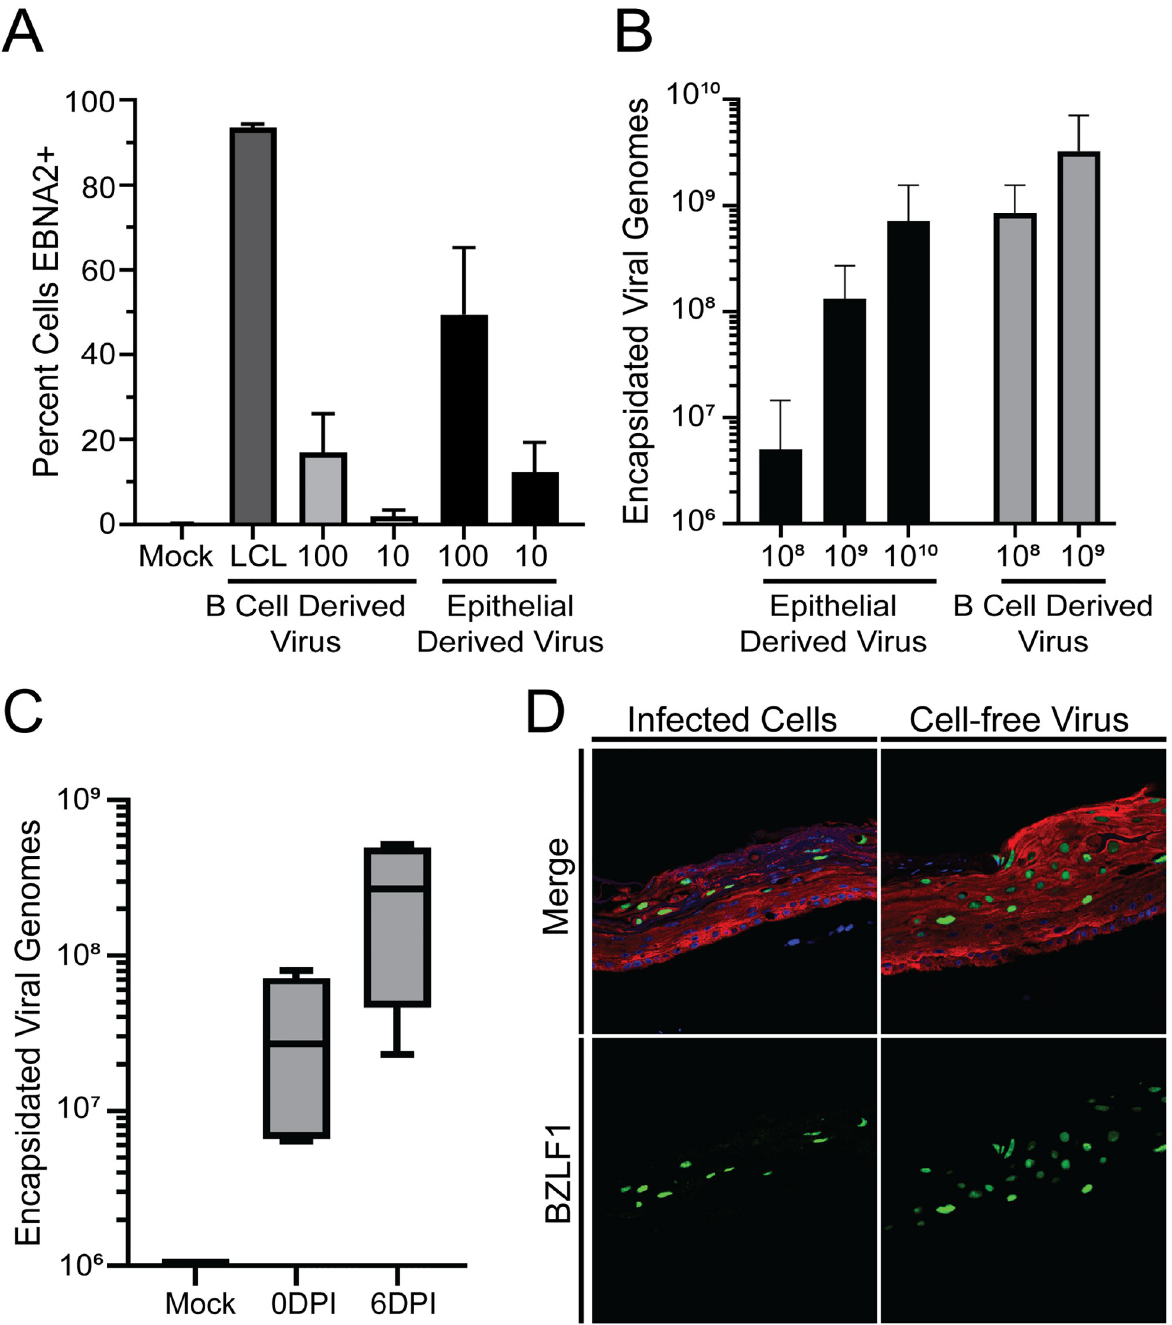
Fig 1. Epithelial-derived virus displays enhanced tropism for primary B cells, while B cell-derived virus has enhanced tropism for epithelial cells. (A) Primary B cells were infected with a multiplicity of infection of either 10 MOI or 100 MOI of cell-free virus derived from virus-producing Akata B cells or epithelial organotypic cultures. The number of infected cells was quantified by counting the number of EBNA2-positive cells in approximately 100 cells at 3 days PI. LCLs were used as a positive control for EBNA2 expression. Infections were performed in triplicate. Bars represent the mean ± SD from 2 donor pools of keratinocytes using 1–4 different virus preps for each. Two-way ANOVA analysis determined that infection in primary B cells was significantly impacted by the cellular source of cell-free virus (p < 0.001). (B) Scored organotypic cultures were inoculated with cell-free virus containing the indicated number of genomes derived from either Akata B cells or from organotypic cultures and collected 6 days PI. The mean ± SD of encapsidated viral genomes in the organotypic cultures from 3 different donor pools are shown. Infection in organotypic cultures was significantly impacted by the cellular source of cell-free virus as determined by two-way ANOVA (p < 0.005). (C) Epithelial cells were isolated from control and infected organotypic cultures at 6 DPI and used to infect a new 4-day organotypic culture. The